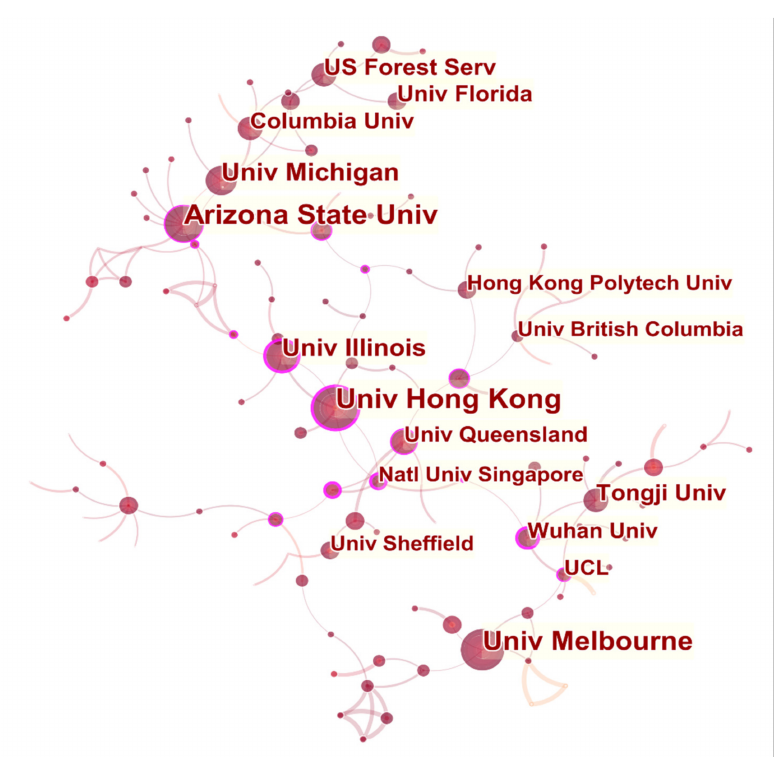
Figure 7. Visualization map of institutions participating in healthy urban planning